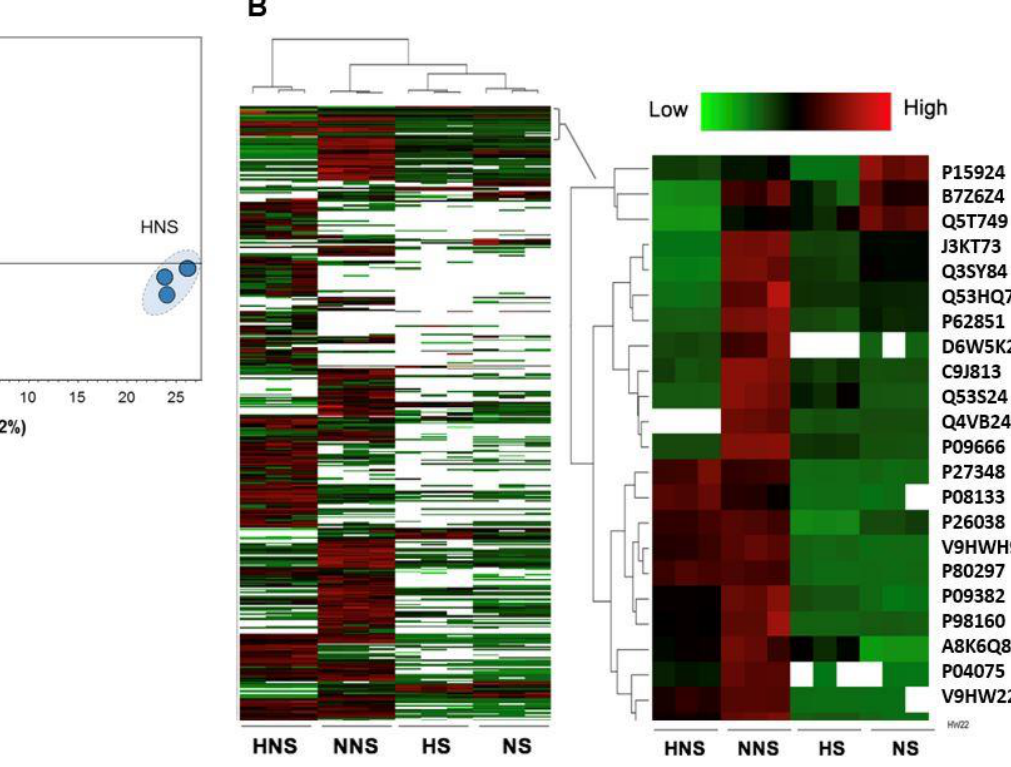
Figure 2. Proteomic analysis demonstrated qualitative and quantitative differences in HBMSC-EV protein content when the HBMSC were not exposed to starvation pre-conditioning. ( A ) Principal component analysis (PCA) of normalized total protein abundance (peak area) of the HBMSC-EV subtypes showed that the protein signatures of the NS (normoxia starvation) and HS (hypoxia starvation) subtypes were similar, while the rich media HBMSC-EV subtypes exposed to normoxia (NNS) and hypoxia (HNS) were significantly different from each other. ( B ) Heat map clustering of the total proteins identified and quantified proteins shows differential abundance among the four HMBSC-EV subtypes that had a distinct enrichment pattern. Overall, HNS HBMSC-EV had the greatest protein variety, with a total of 395 proteins identified with 74 unique proteins. NNS HBMSC-EV had the second most total proteins, with 367 proteins identified and 14 unique proteins. The NS and HS HBMSC-EV subtypes had the lowest number, with 276 and 235 total proteins, respectively (Figure 3A). A total of 172 proteins were common in all HBMSC-EV types (Figure 3A). Pathway analysis of these proteins showed pathways with regenerative or adaptive roles, such as “carbon metabolism,” “biosynthesis of amino acids,” “HIF-1 signaling pathway,” and “ribosome”, were enriched (Figure 3B). Furthermore, pathway analysis of the 74 unique HNS proteins demonstrated that pathways involved in angiogenesis, such as “cell migration,” “cell adhesion,” and numerous inflammatory pathways, were enriched (Figure